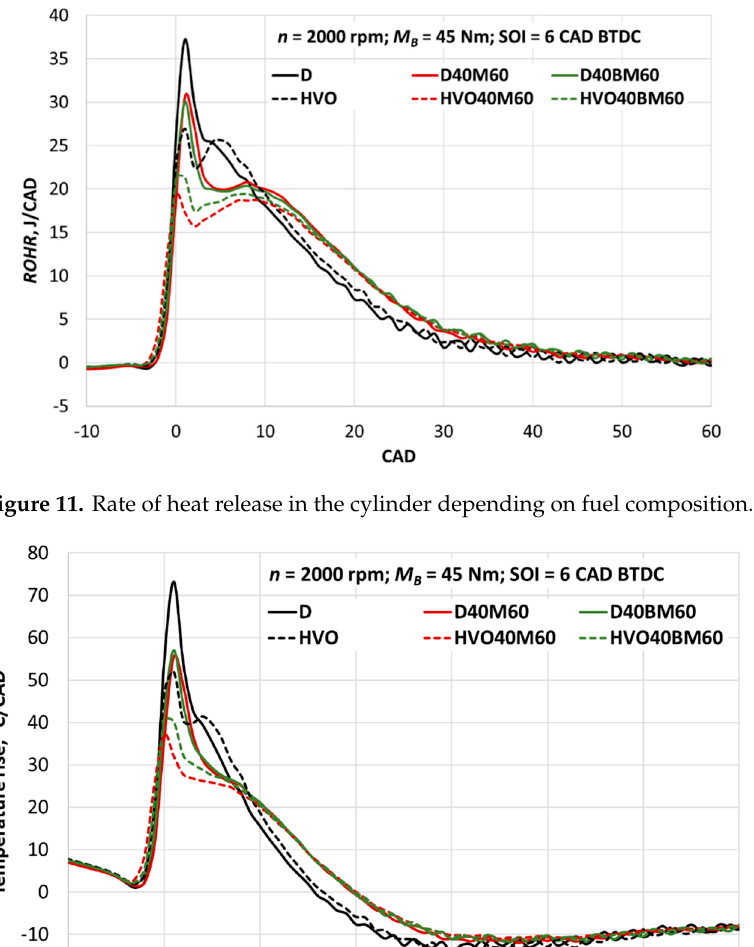
Figure 11. Rate of heat release in the cylinder depending on fuel composition.